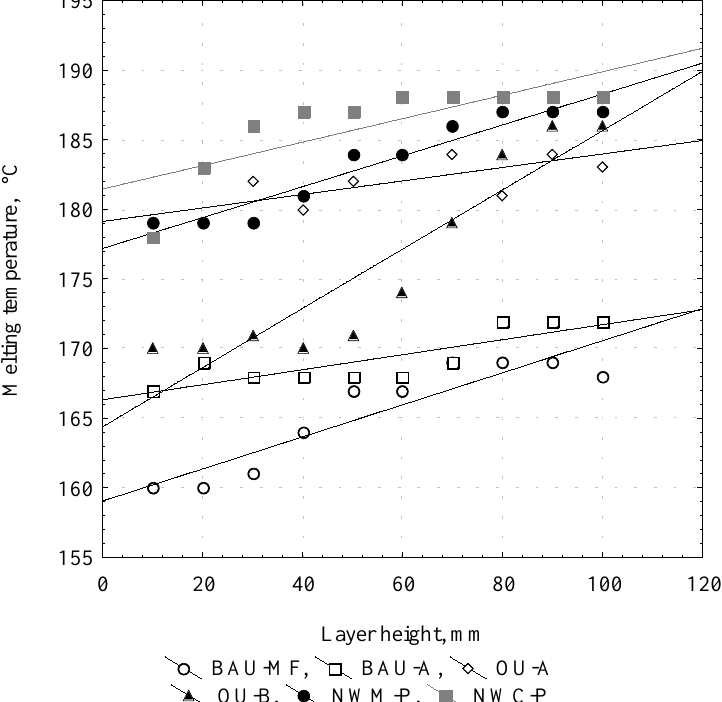
Fig. 3. Dependence of rutin melting temperature on adsorbent layer